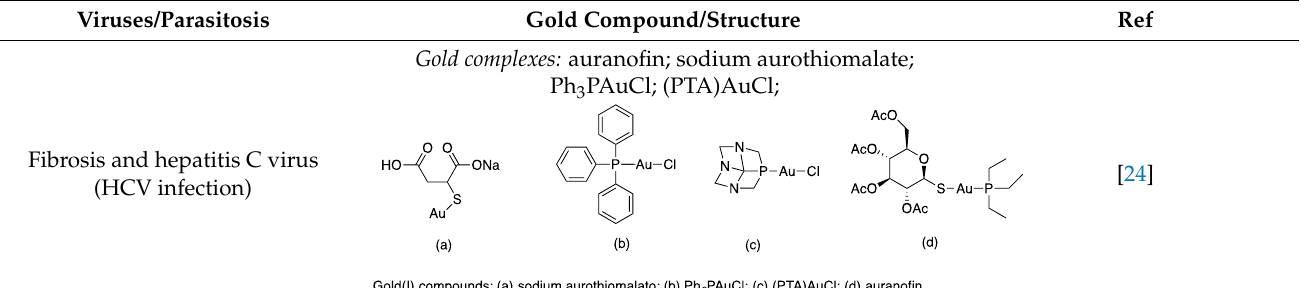
Table 1. Gold compounds with structures and biological effects against viruses and parasitosis. Viruses/Parasitosis Gold Compound/Structure Ref Gold complexes: auranofin; sodium aurothiomalate;